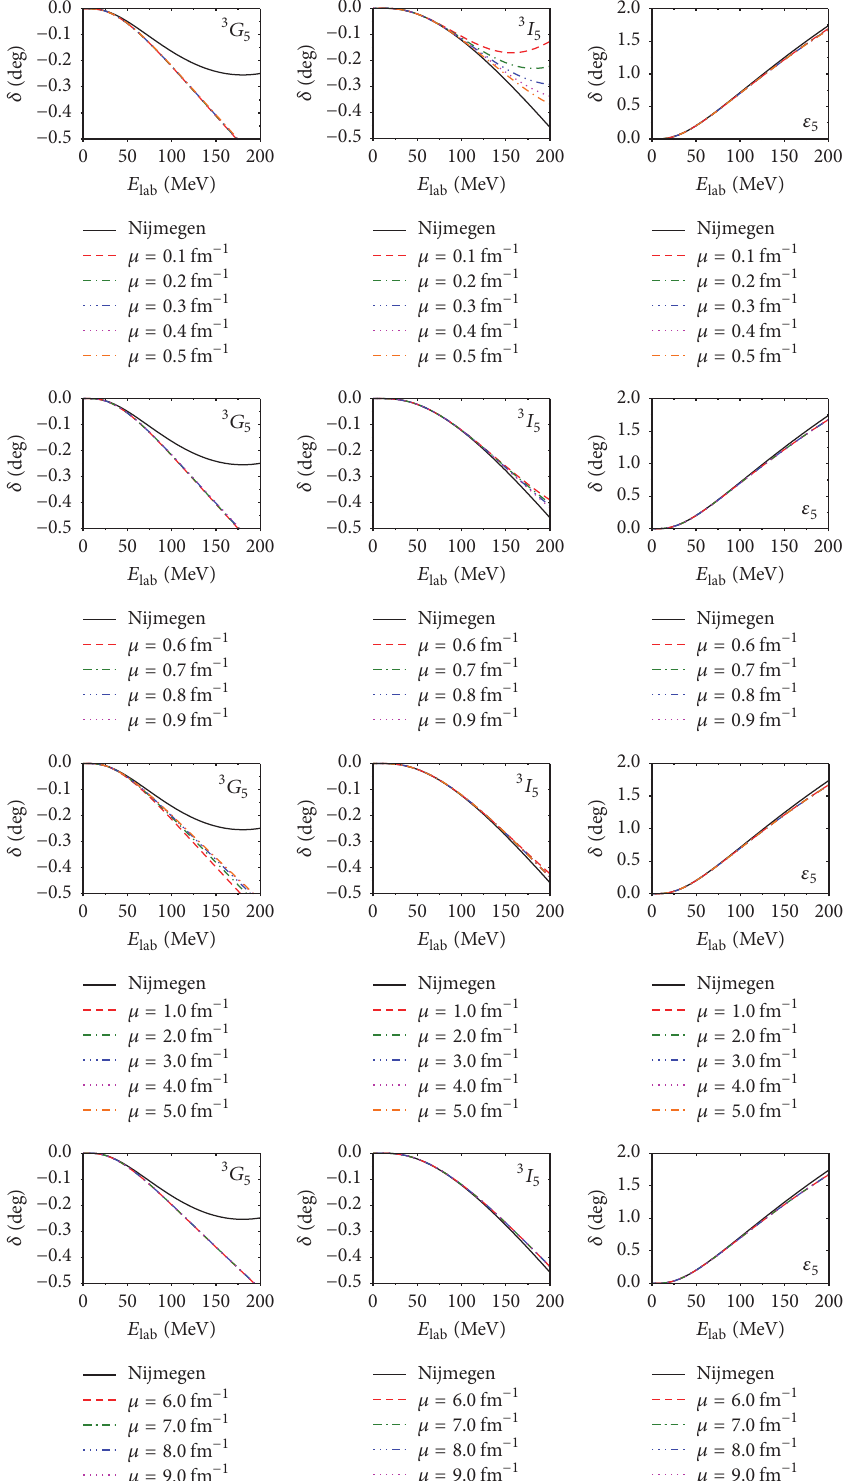
Figure 6: (Color on-line) phase shifts in 3 𝐺 5 − 3 𝐼 5 coupled channels calculated from the solution of the subtracted LS equation for the 𝐾 - matrix with five subtractions for the N3LO-EM potential for several values of the renormalization scale compared to the Nijmegen partial wave